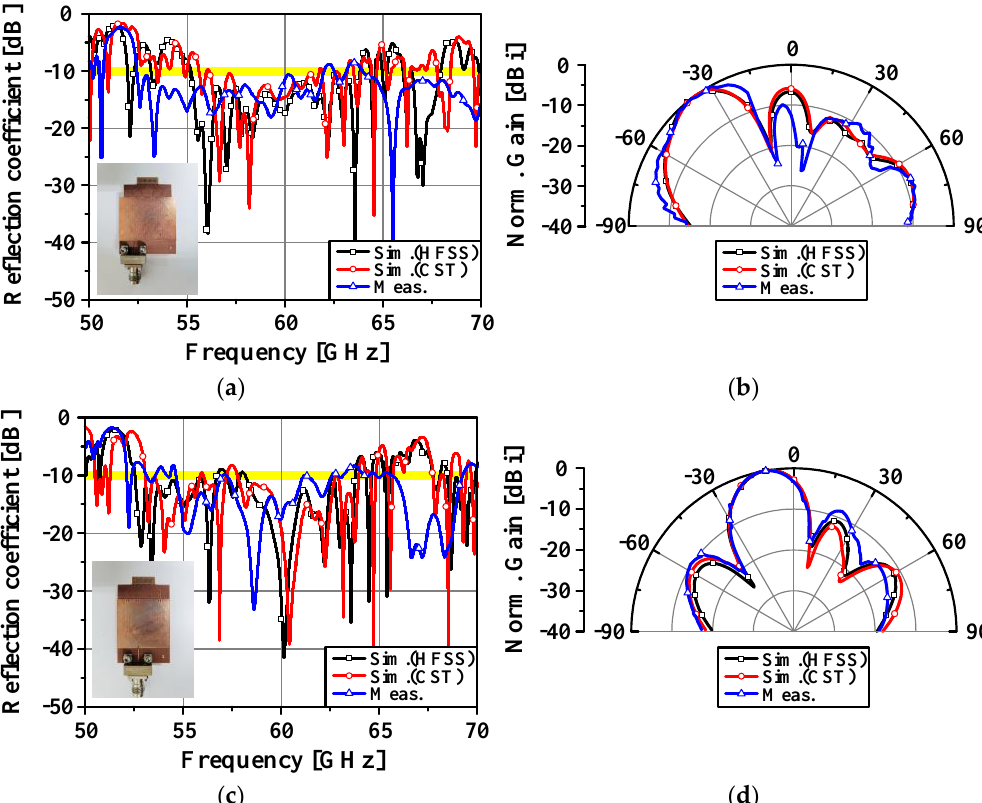
Figure 18. Measured results of reflection coefficient and radiation pattern: ( a ) reflection coefficient for